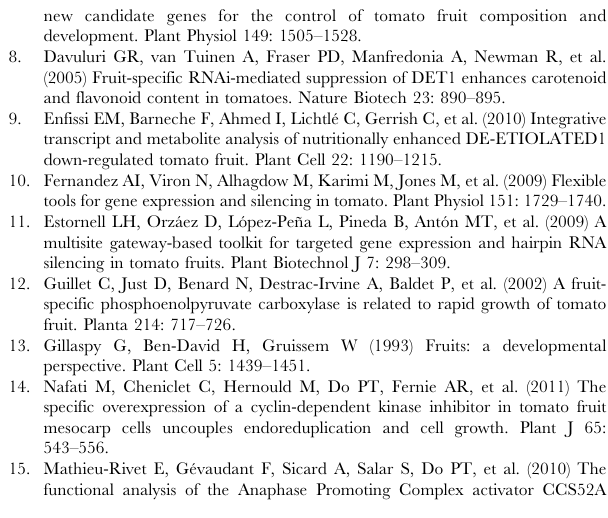
Figure S2 Determination of the transcription start point of the SlPPC2 gene by primer extension analysis. Lane PE shows the extension product obtained after reverse transcription using a SlPPC2 -specific oligonucleotide primer. The band, indicated by an arrow, corresponds to a G located 442 nucleotides upstream from the ATG codon. The sequencing ladder was generated using the same primer on a cloned fragment of the SlPPC2 genomic clone. Sequence upstream from the transcription start site is presented, showing location of putative TATA box. Figure S3 Carbohydrate content of tomato fruit slices incubated on medium supplemented with various sugars. (A) Sucrose; (B) Glucose; (C) Fructose; (D) Starch; (E) Malic acid; (F) Citric acid. Eight (8) daa tomato fruit slices were incubated or not (no incubation) for 20 h on CPW4 medium containing 50 mM mannitol, 5 mM to 100 mM sucrose, 50 mM 3-OMG, 50 mM 2-dG, 50 mM glucose or 50 mM fructose. Data are means 6 SE (n= 3).